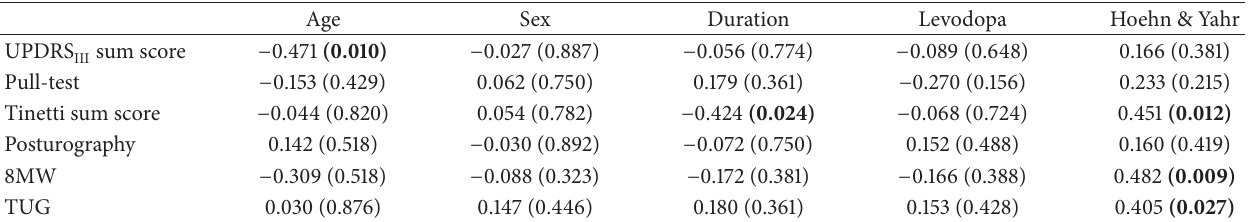
Values are indicated as mean ± SD; “pre” indicates baseline scores, “post” indicates scores after the last treatment. Significant 𝑝 values are bold. Differences are reported as absolute value and percentage. Table 4: Pearson’s correlations (significance) of motor symptoms’ change after treatment with age, sex, duration of disease, levodopa dosage, and falls frequency in the treatment